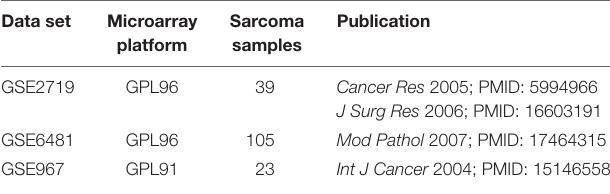
TaBle 1 | Summary of the three GEO data series used in this study. Data